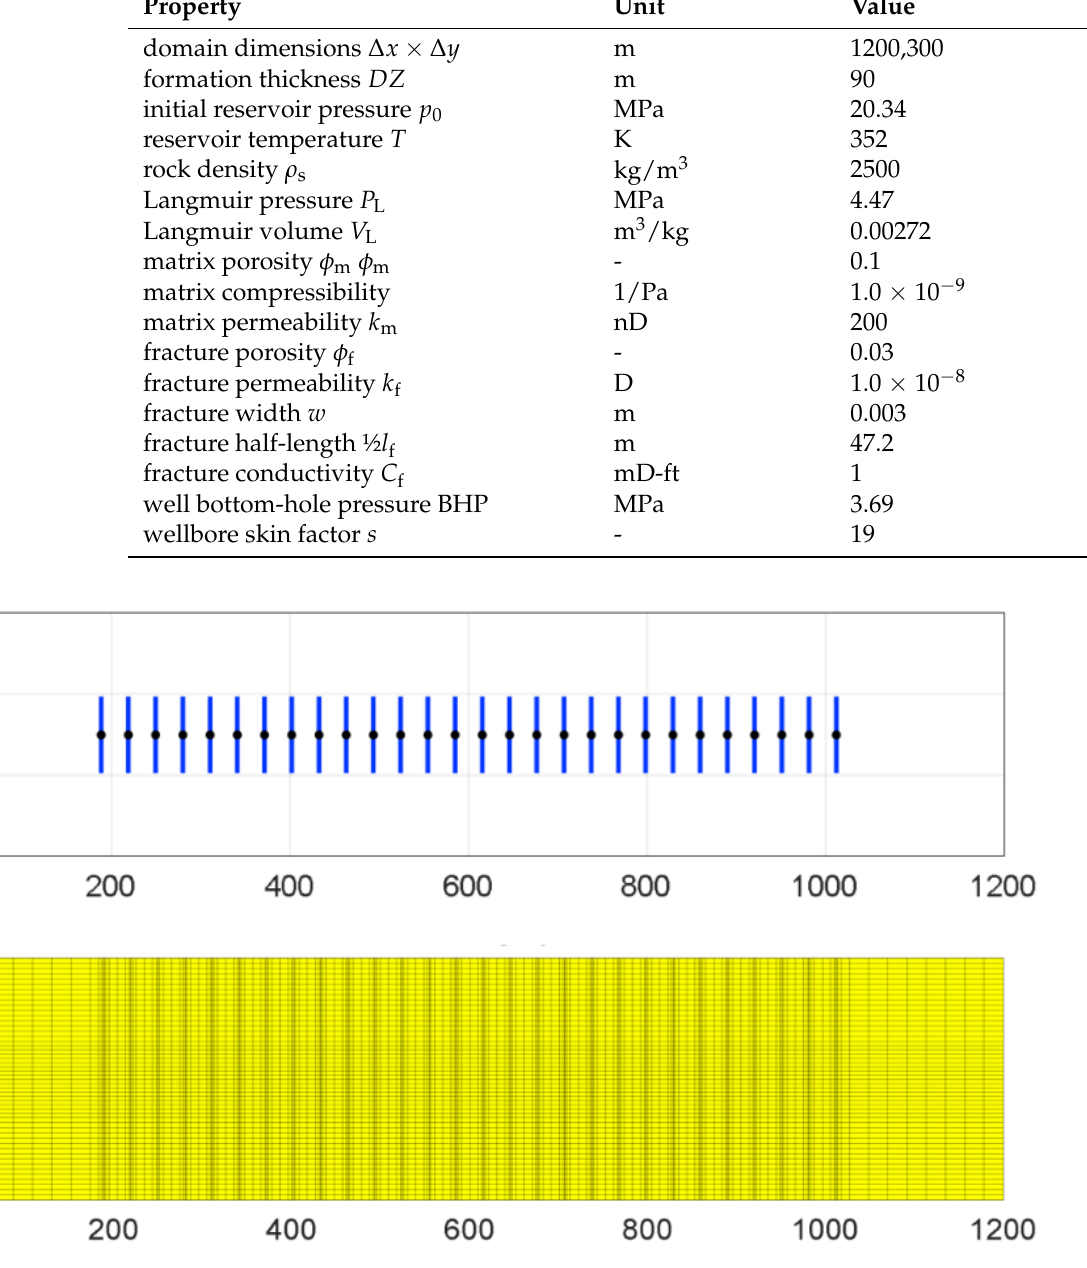
Figure 19. AE1 simulation scheme ( top ) and relative EDFM grid with 28 linear HFs ( bottom ). In Figure 20, the pressure contours, derived from the ShOpen simulation, after 1600 days are